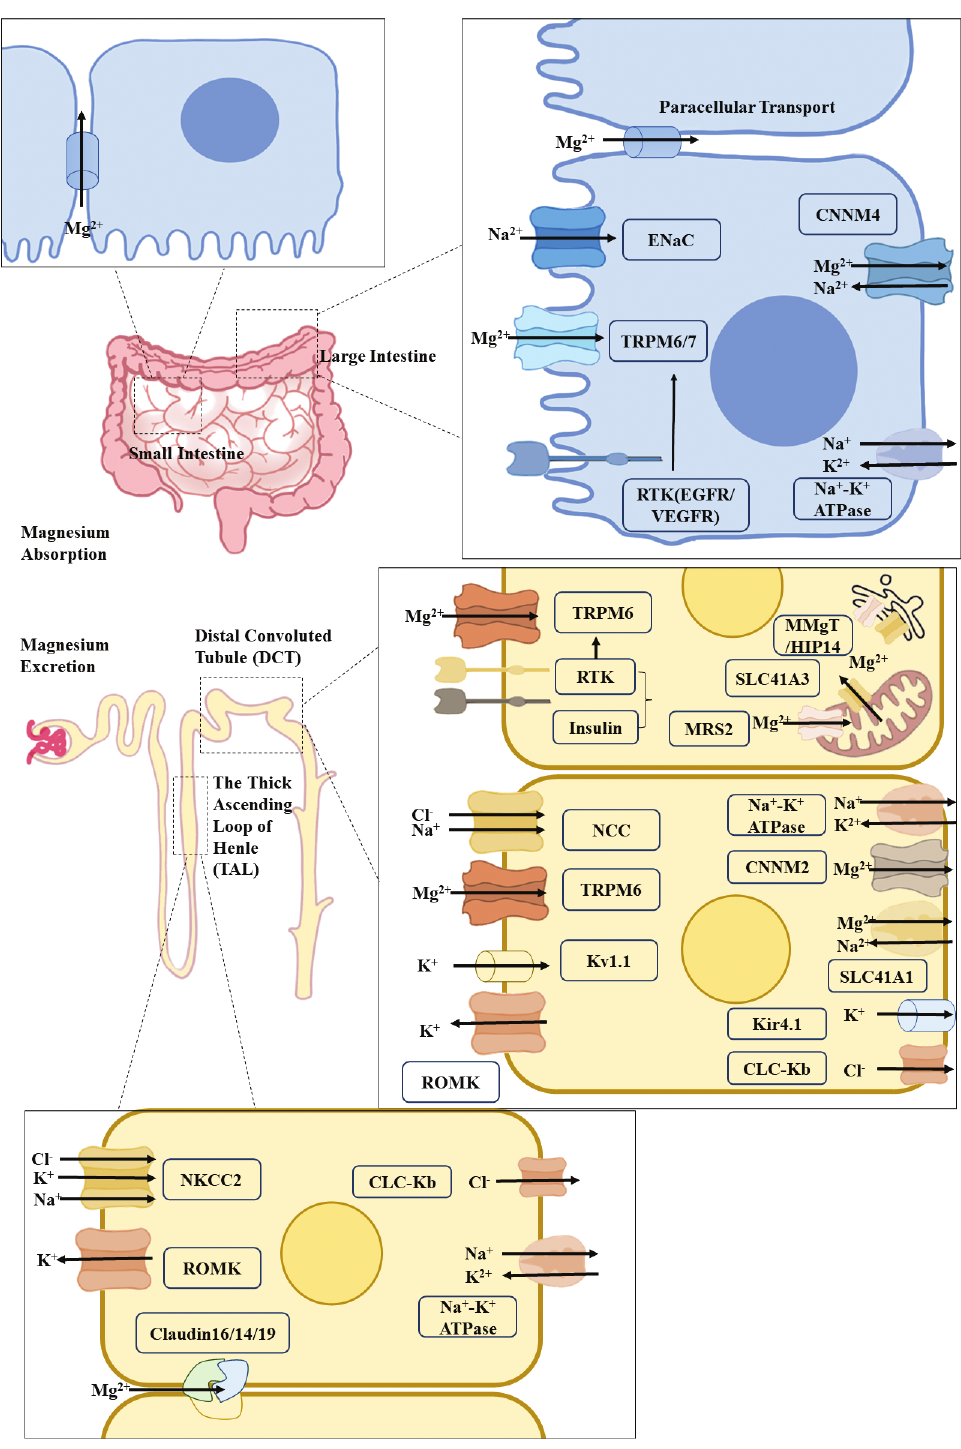
Fig. 1. Mechanism of Mg 2+ balance in the body. Mg 2+ is absorbed mainly in the intestine and excreted through the kidney. Clau- din-16, Claudin-19, TRPM6/7, Mrs2, SLC41A1/3, and CNNM2/4 are transporters of Mg 2+ . Receptor tyrosine kinase (RTK) and its ligands such as epidermal growth factor (EGF) influence Mg 2+ homeostasis by regulating Mg 2+